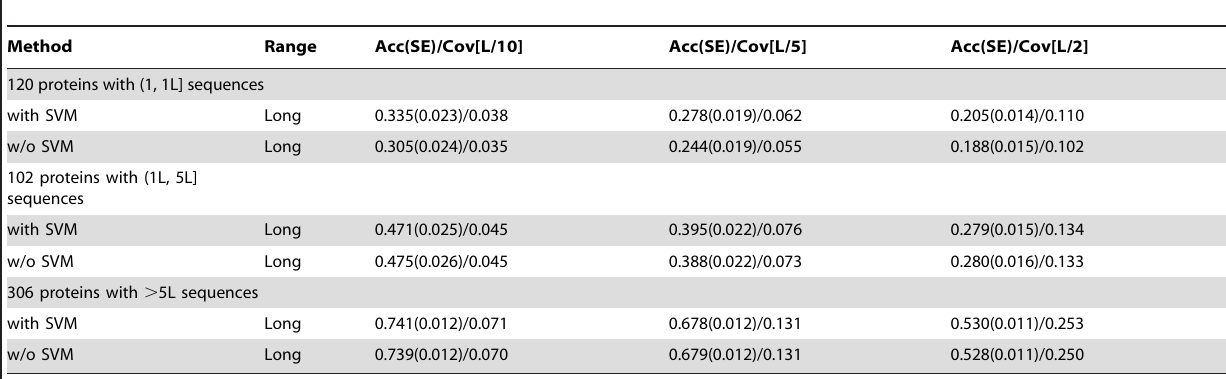
Table 2. Contribution of the SVM component to contact